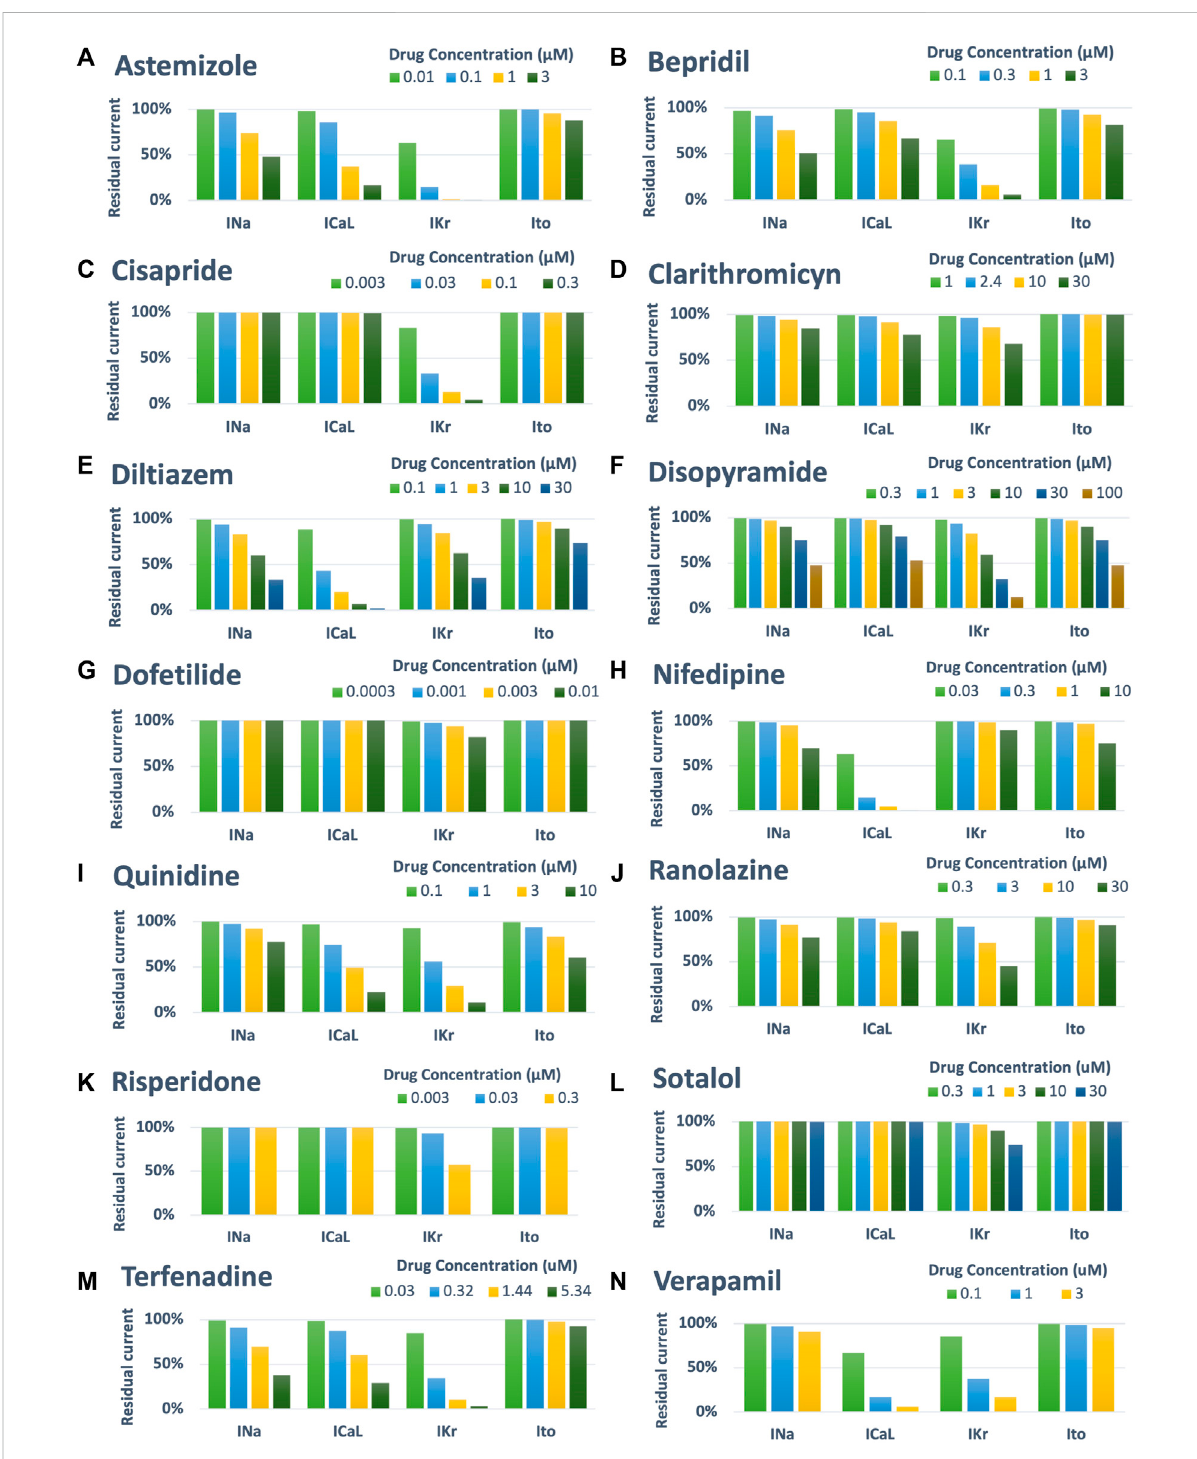
FIGURE 2 Summary of drug-induced effects on the cardiac ion channels, computed with a simple pore-block model. Each panel shows one of the fourteenreferencecompounds,withthedifferentbarsrepresenting theresidualcurrentafter drug-application(in percentage), for eachionchannel and drug